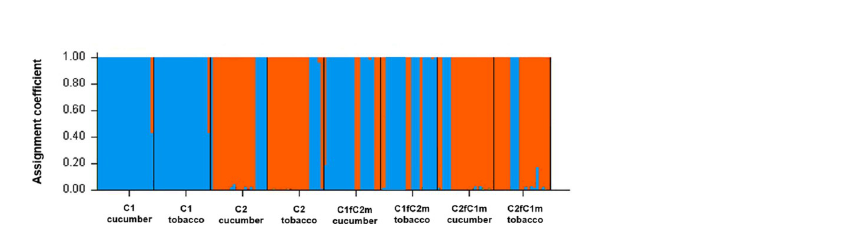
Table 3. Total fecundity, daily fecundity, longevity, oviposition period, and post-oviposition period (mean ± S.E.) of female B . tabaci (n = 30). Host plant Treatment